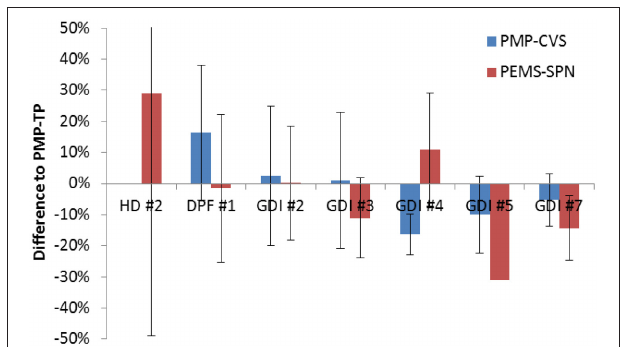
FIGURE 1 | Deviations between SPN emissions measured with various systems at various sampling locations. Error bars show one standard deviation of SPN emissions measured over > 10 phases of various driving cycles. All tests were conducted in the laboratory, except the comparison of PMP-TP with the PEMS-SPN for HD #2 and GDI #5 that were conducted on the road (on-board).